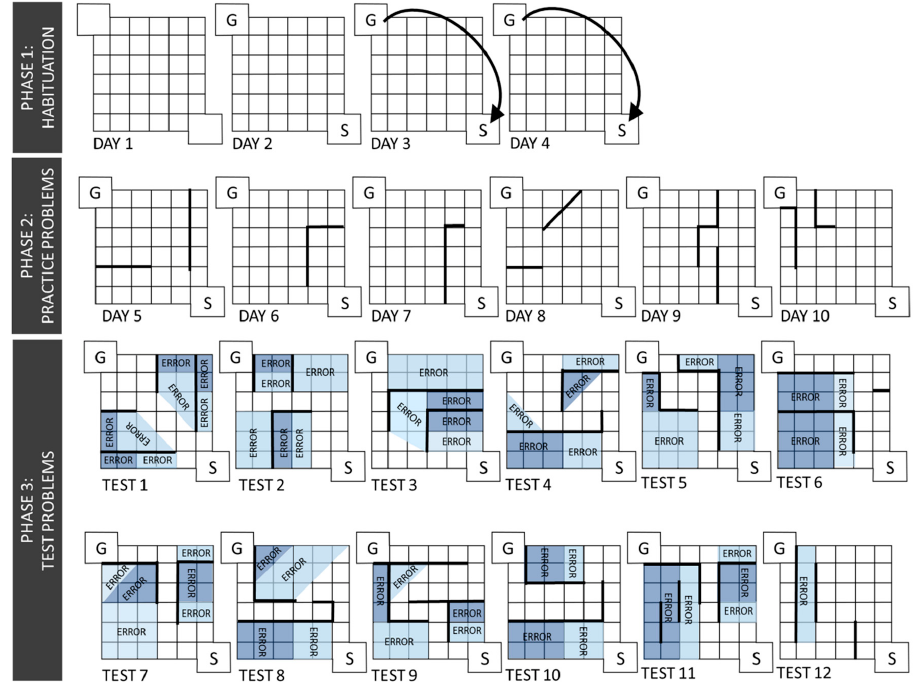
Figure 2. Hebb ‐ Williams maze configurations. The above maze configuration and testing procedures were adapted from Rabinovitch and Rosvold [25]. Testing consisted of three phases: habituation, practice, and test. During the habituation phase, rats were acclimated to the testing apparatus and trained to run from the start box (S) to the goal box (G). Then, rats went through 6 di ff erent practice problems, followed by 8 runs each of 12 test problems. Each test problem has error zones, and an error was scored when the rat entered the incorrect zone, as determined by a blind observer. Each problem varied in di ffi culty level so that easy and di ffi cult problems were dispersed throughout the testing